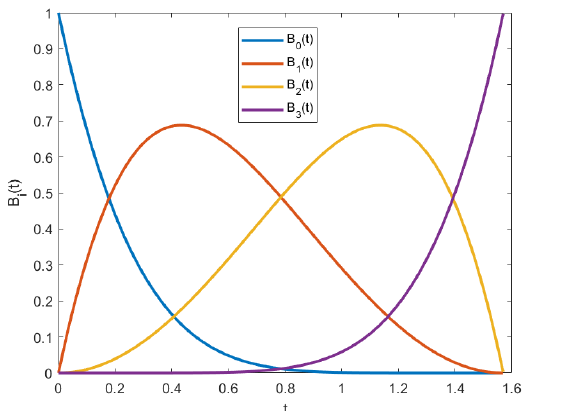
Figure 1. The plot of the generalized quasi cubic trigonometric Bernstein basis functions with α ( t ) and β ( t ) given in Equation